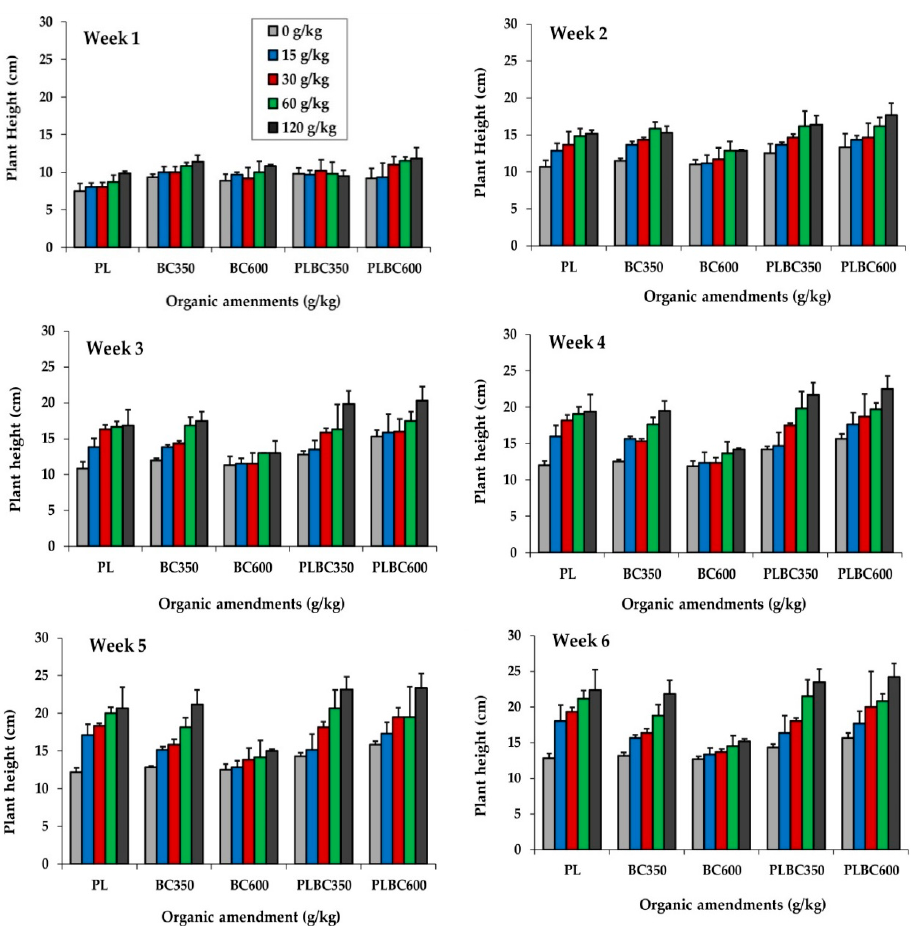
Figure 3. Effects of poultry litter and its biochar on Jatropha plant height from week 1 to week 6 at different application rates of 0, 15, 30, 60 and 120 g/kg recorded on weekly basis. Error bars correspond to the standard error ( p < 0.05).